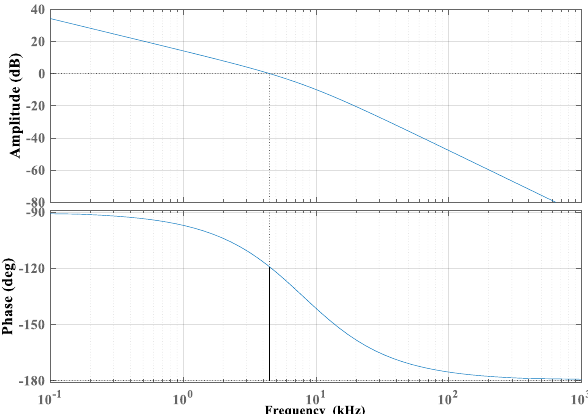
Figure 7. The system amplitude – frequency characteristic curve cluster: ( a ) when S r when varies.